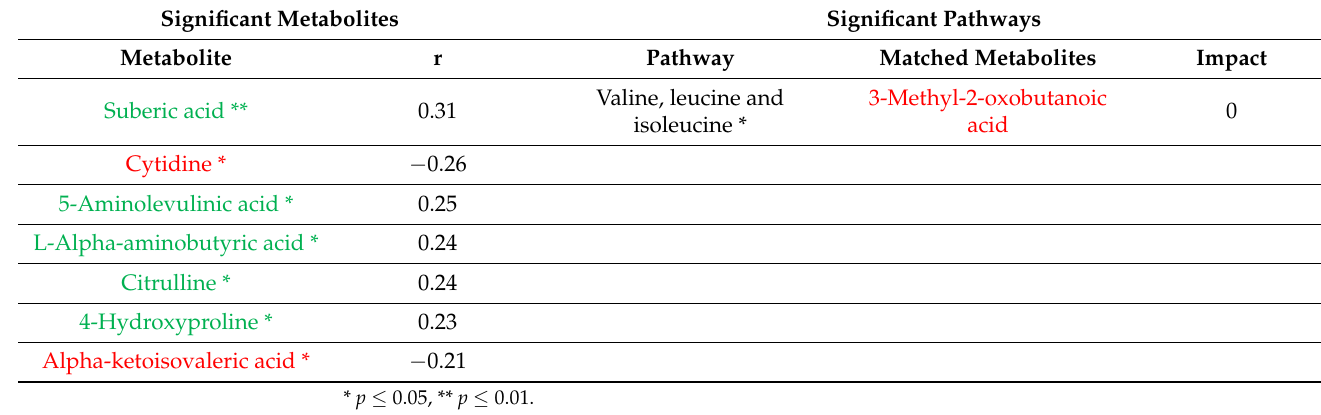
Table 13. Metabolites and their pathways which correlate with the intracellular glutathione redox ratio.